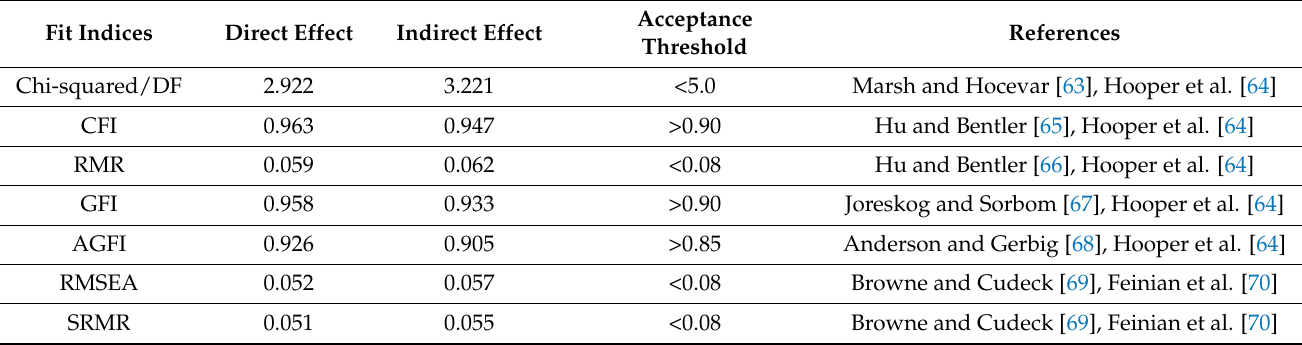
Table 5. The model fit indices and their acceptable thresholds.